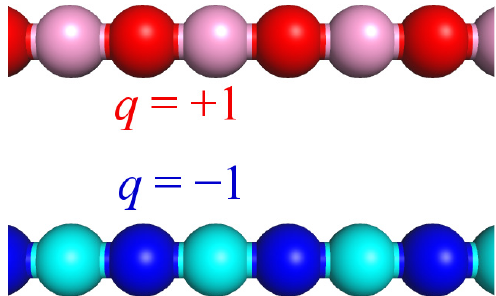
Figure 1. Schematic representation of the studied macromolecules. In all the snapshots, non-charged and charged groups of the hydrophobic chain (polycation) are depicted by light-red and dark-red beads, respectively, while non-charged and charged groups of the hydrophilic chain (polyanion) are shown by light-blue and dark-blue beads, respectively.